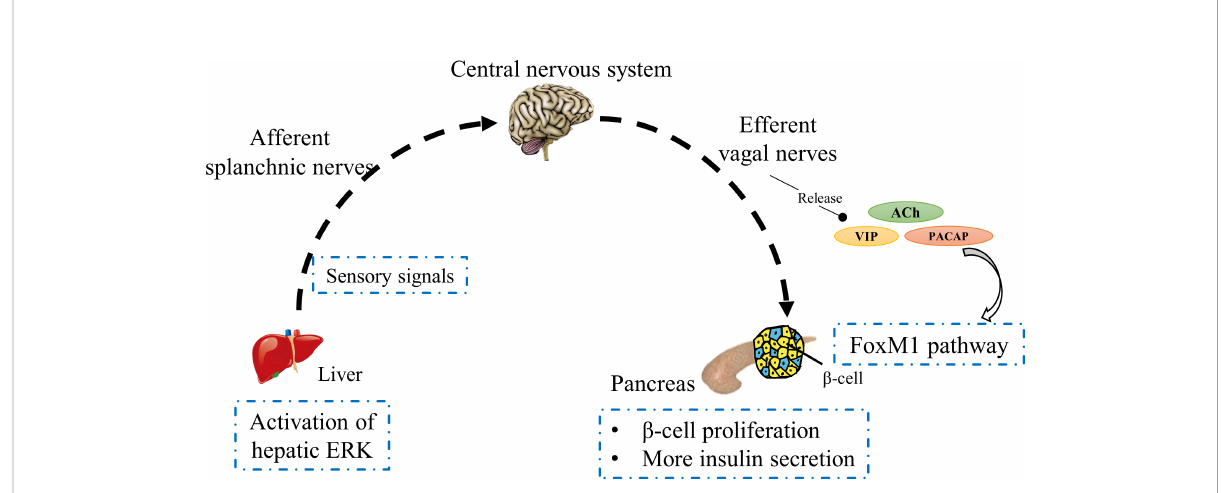
FIGURE 2 Schematic of a liver – brain – pancreas neuronal relay. In insulin-resistant individuals, hepatic ERK activation transmits sensory signals to the central nervous system through the afferent splanchnic nerves, which in turn reach the pancreas via vagal nerves. Vagal factors induce islet b - cell proliferation to secrete more insulin through activation of the FoxM1